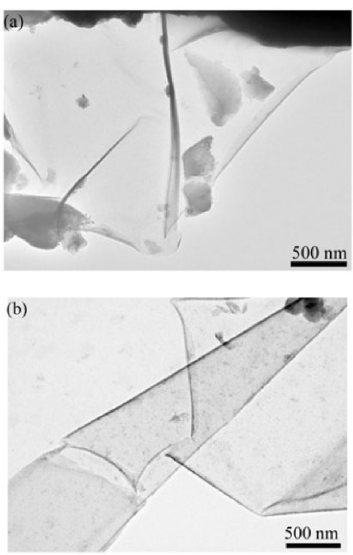
Fig. 3 TEM images of (a) Ti 3 C 2 T x and (b) V 2 CT x .